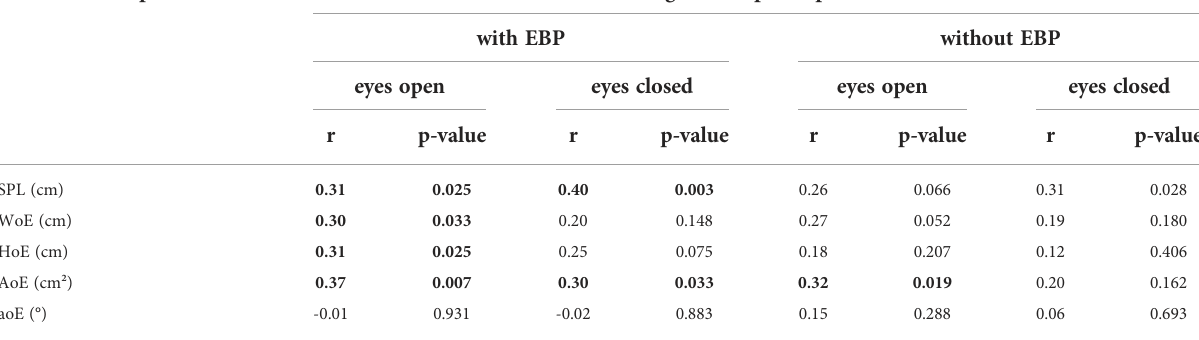
TABLE 8 Correlation of posturometric parameters with the age of the participants. Posturometric